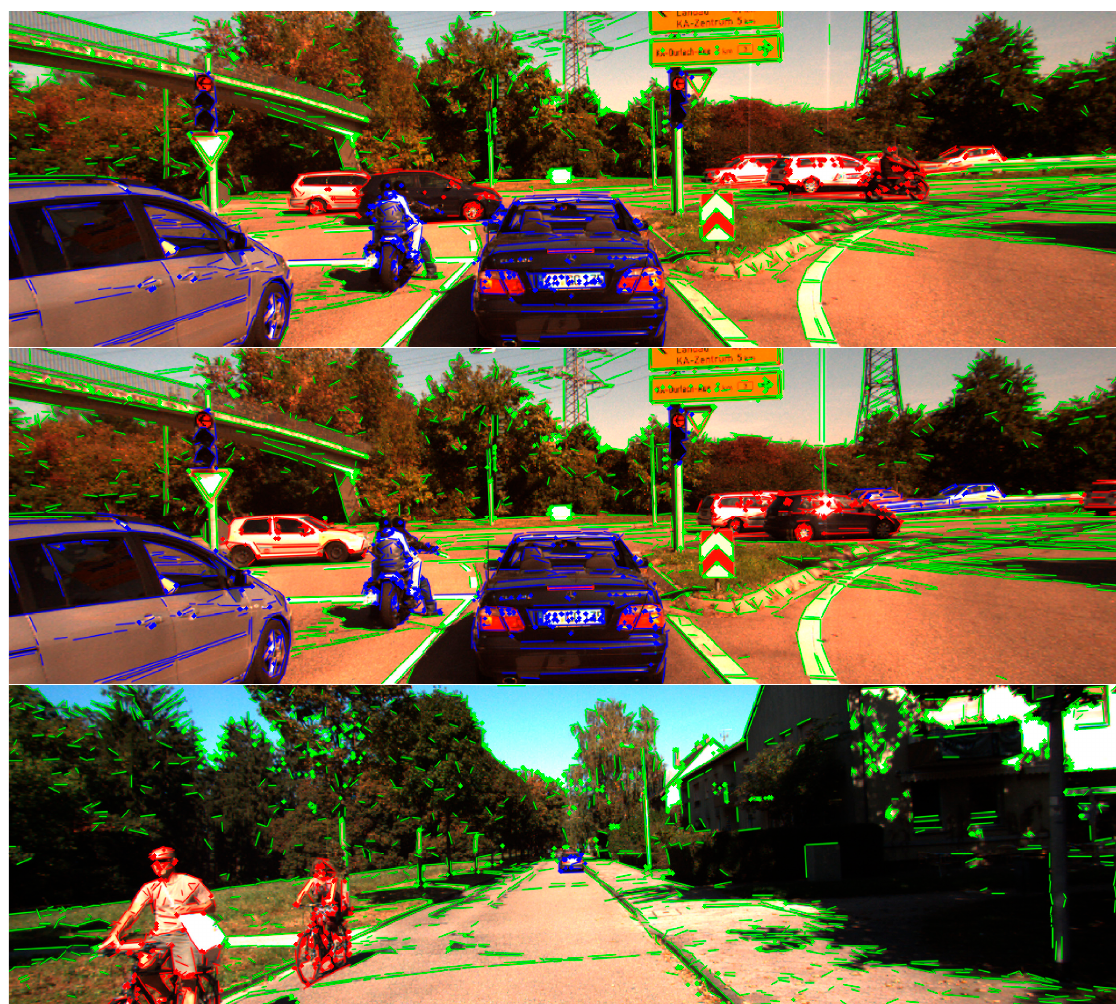
Figure 8. Dynamic object and static object separation experiment, in which the blue point and line is the static object, and the red point and line is the dynamic object.